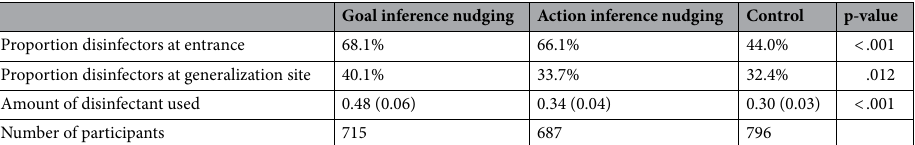
Table 5. Proportions and means for dependent variables of Study 3. The table reports the proportions, means, and standard deviations (in parentheses) of all dependent variables in Study 3, the p-value of the effect of condition in an ANOVA for each variable, and the number of participants in each